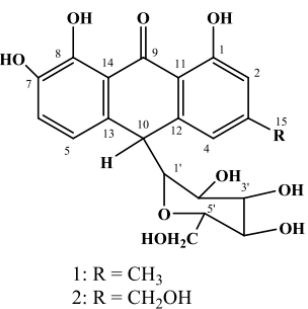
Figure 1. Chemical structures of nataloin ( 1 ) and 7-hydroxyaloin ( 2 ).